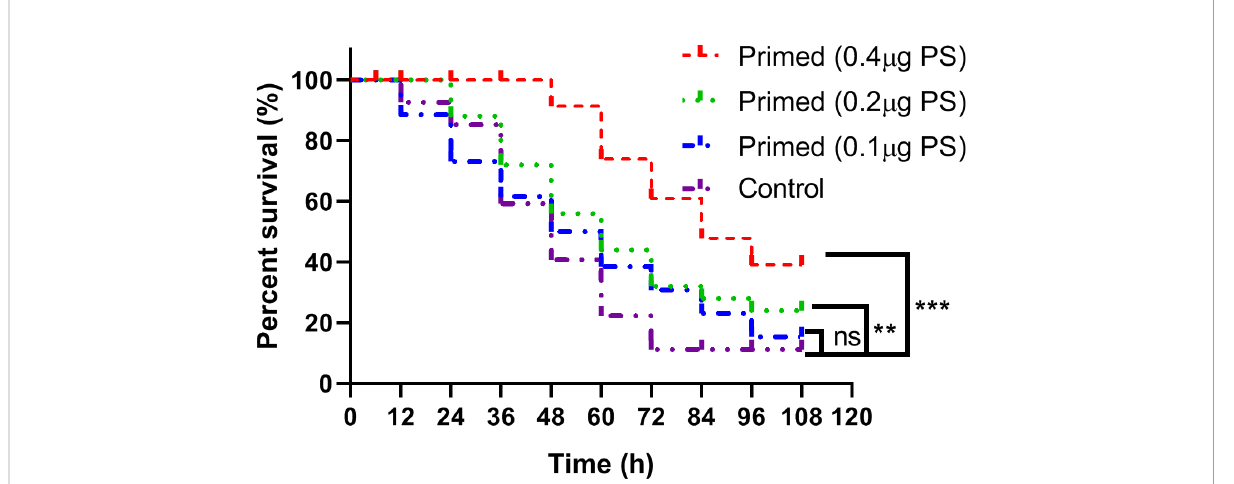
FIGURE 2 Kaplan – Meier curve analysis of Bombyx mori larvae immune-primed with different doses of Poria cocos polysaccharides followed by infection with a lethal dose of Bacillus thuringiensis at 24 h post-priming. ** , *** and ns indicate signi fi cance at P ≤ 0.01, P ≤ 0.001 and non-signi fi cant, respectively.